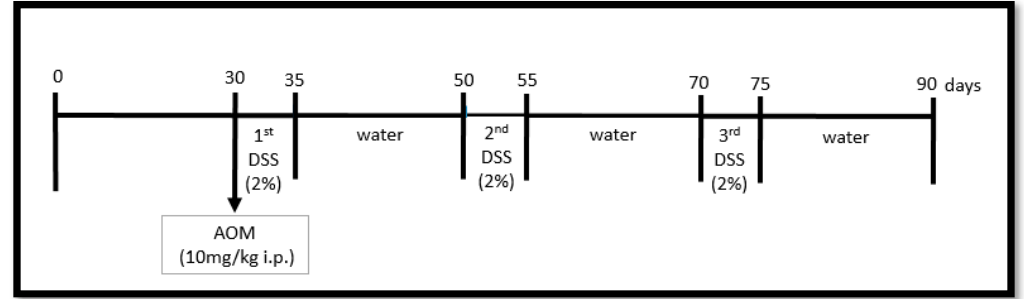
Figure 1. Colon carcinogenesis experimental protocol: colon carcinogenesis was induced chemically by a single dose of azoxymethane (AOM), with 10 mg/kg body weight administered intraperitoneally on the 30th day, and subsequently three cycles of dextran sodium sulphate (DSS) consisted of 5 days drinking DSS and 15 days drinking water. The diet started on day 0 and finished on the 90th day. BW, food intake, and water consumption were measured once a week. The animals’ health and well-being were monitored three times a week.